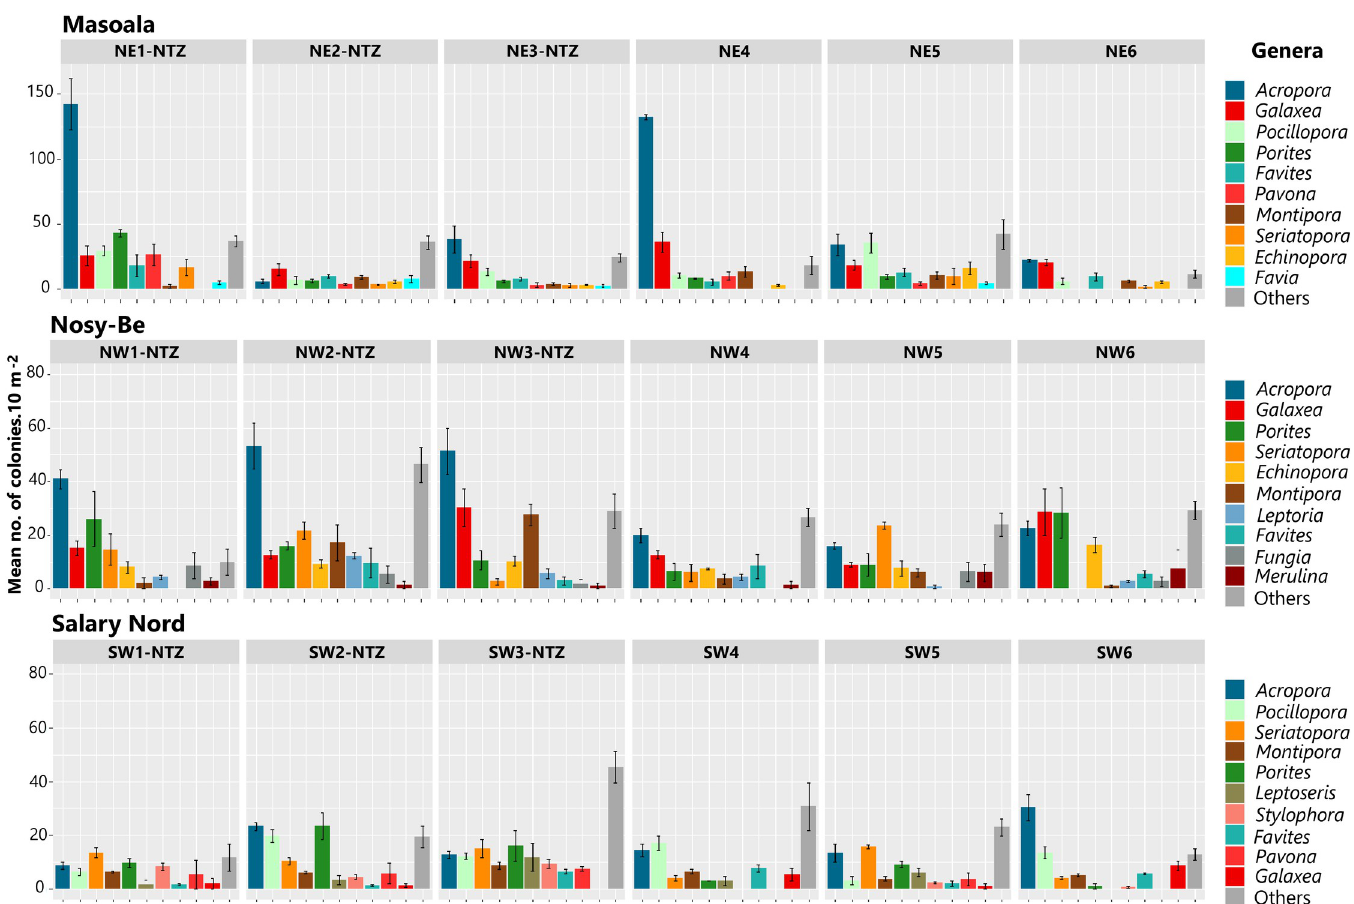
Fig 5. Spatial variation in the abundance of the 10 major coral genera and other less represented genera (“others”). Data are given for 18 sampling stations located at the three regions. Errors bars represent standard error. the 10 dominant corals at only one of the three regions, as Favia at Masoala, Leptoria , Fungia and Merulina at Nosy-Be, and Leptoseris and Stylophora at Salary Nord (Fig 5). Coral assemblages were dominated by stress-tolerant taxa at 11 of the 18 stations, whereas competitive taxa were the most represented life history strategy at NE1-NTZ and NE4 in Masoala and, to a lesser degree, at NW1-NTZ in Nosy-Be (Fig 6 and S12 and S13 Tables). Generalist and weedy taxa were generally less abundant except at stations NE5 in Masoala and SW1-NTZ and SW2-NTZ in Salary Nord. Five models were selected as the most parsimonious to explain the variation in the abundance of the four life history strate- gies (Tables 3 and S14 and S15 and S9 Fig). Region, fishing protection level, life history strategies, herbivorous fish biomass, and the interactions of region × fishing protection level, region × life history strategies, fishing protection level × life history strategies, and region × fishing protection level × life history strategies had the maximum value of relative importance (1.000). Rugosity (0.322), macroalgae cover (0.526), turf (0.169), and CCA (0.169) were also selected by the models, but their relative importance was lower. The mod- els underlined the higher abundance of competitive corals at some Masoala stations, the higher abundance of competitive corals in unfished stations at Nosy-Be, and the higher abundance of weedy corals in unfished stations at Salary Nord.